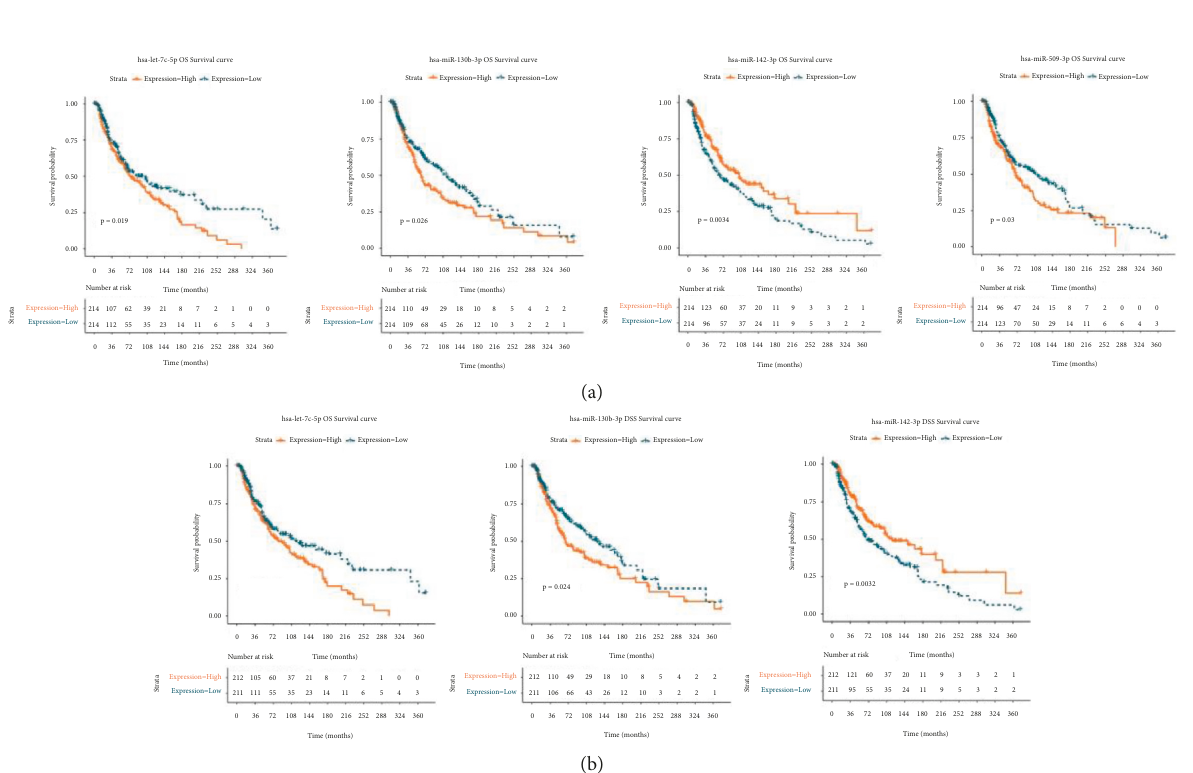
Figure 4: Survival analysis. (a) Four miRNAs associated with overall survival (OS). (b) Three miRNAs correlated with disease-specific survival